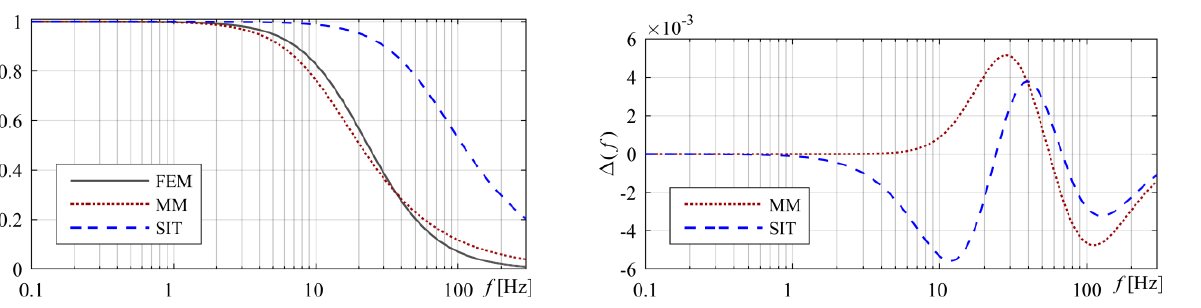
Fig. 7. MT3 model matching error.